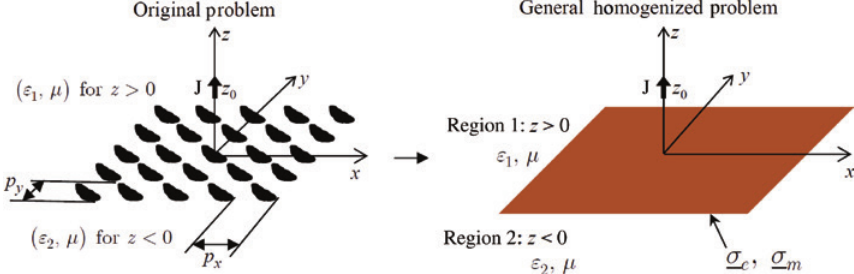
Figure 2: Analytical modeling of metasurfaces. Original problem of a planar array of meta-atoms in a host medium/structure (left) and the corresponding equivalent homogenized problem (right) represented as a generic sheet with electric conductivity tensor σ from Ref.